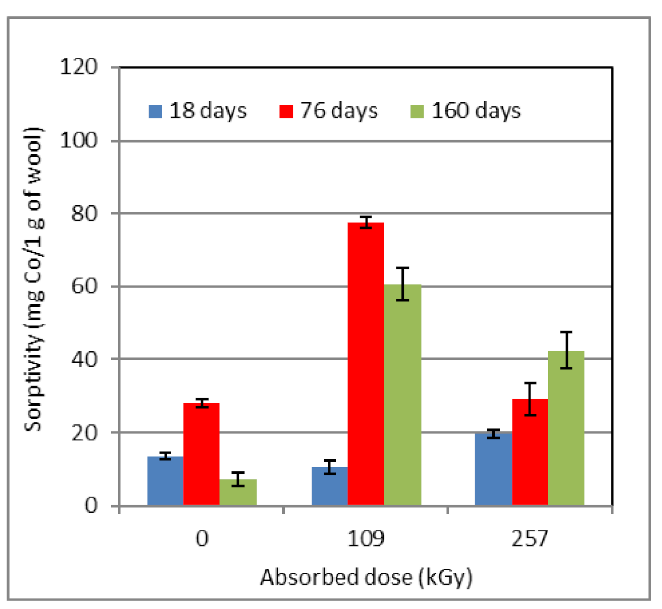
Figure 7. Time sorptivity variation with absorbed dose for wool pre-conditioned at 97% RH.